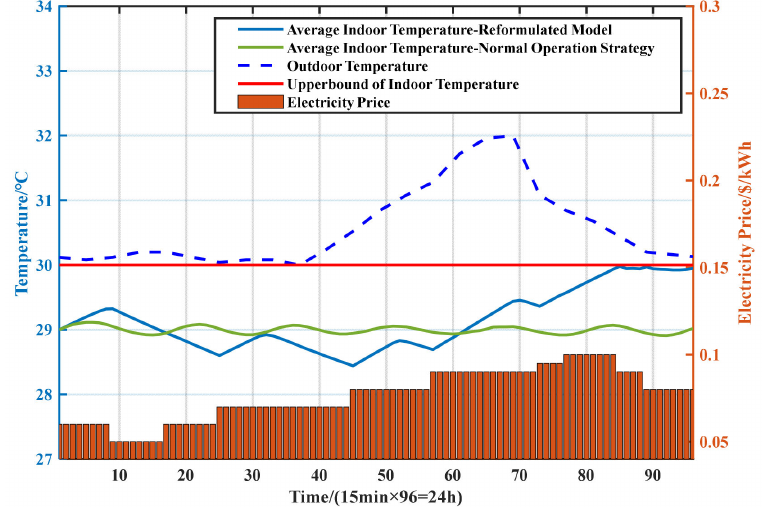
Figure 11. Average indoor temperature.